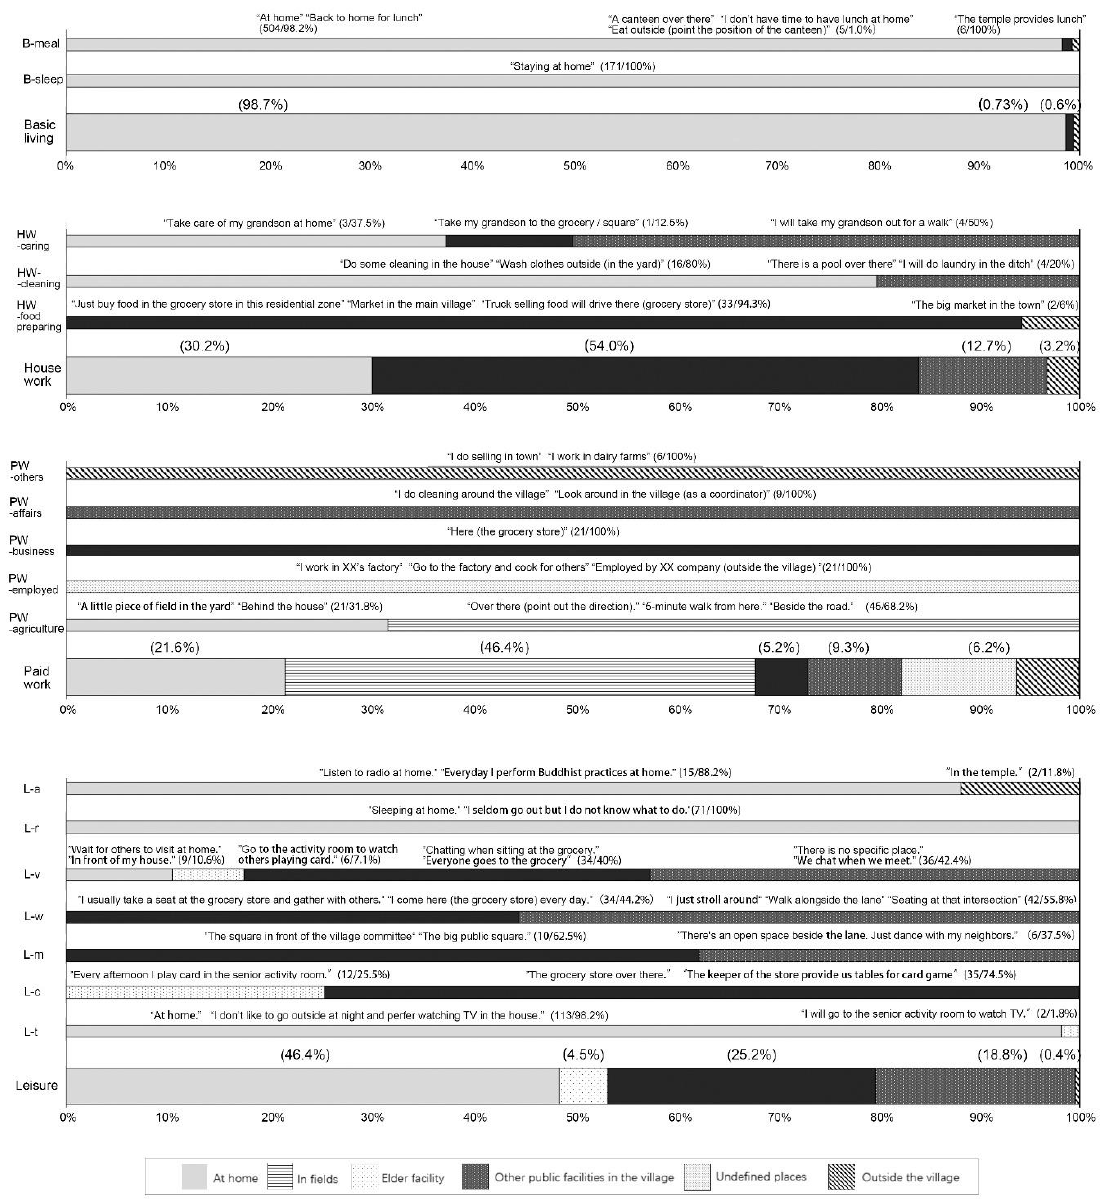
Figure 3. Sample words and categories representing the locations of daily activities.